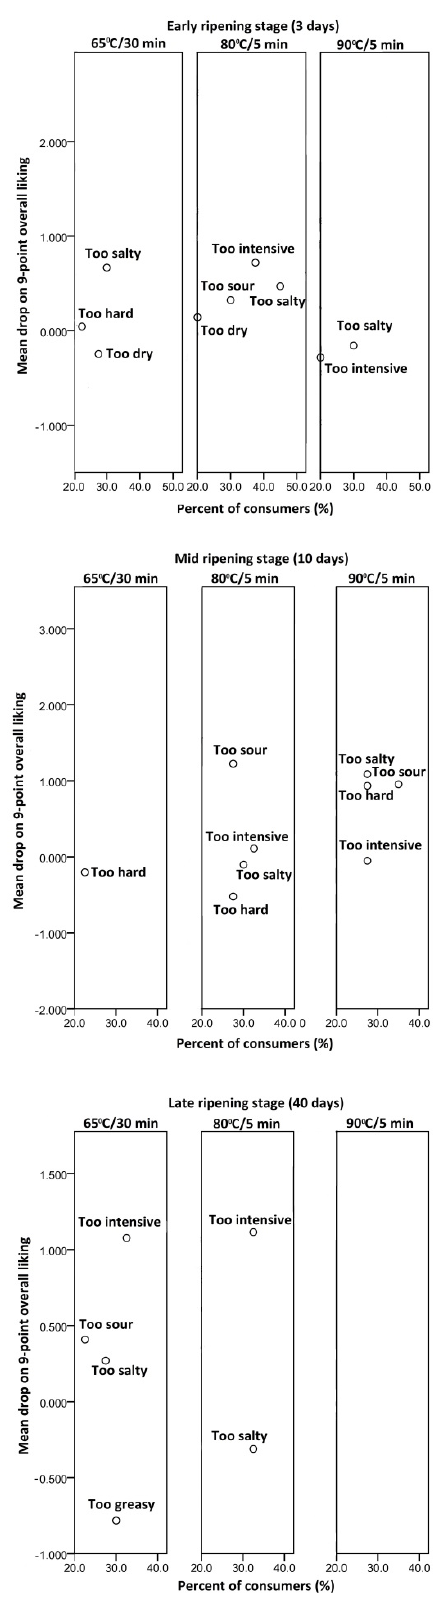
Figure 2. Mean drop analysis of goat cheeses produced from milk heated to 65 ◦ C/30 min, 80 ◦ C/5 min and 90 ◦ C/5 min, in the early (3 days), mid (10 days) and late (40 days) stage of